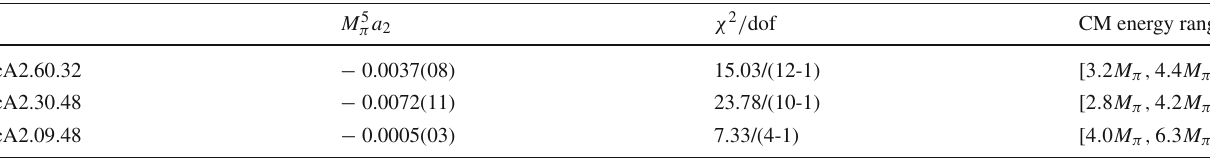
Table 5 Summary of some lattice and phenomenological determina- tions of the isospin-2 ππ scattering length at the physical point. Note that the lattice determination of ETM (2015) is the only one with chiral and continuum extrapolations. We list LO ChPT, ChPT and